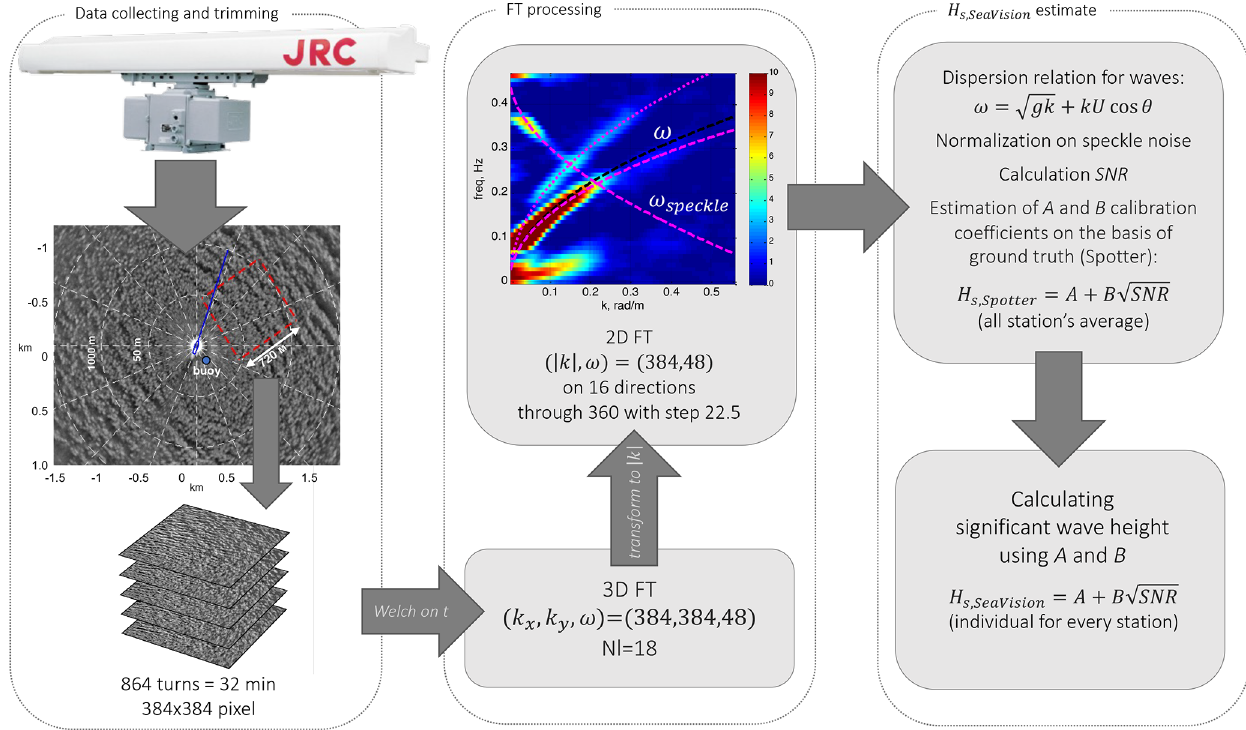
Figure 3. Organigram of the data processing for estimation of wind wave parameters from the sea clutter images. JRC radar scanner (top left) is taken from http://www.jrc.co.jp/eng/index.html (last access: 4 August